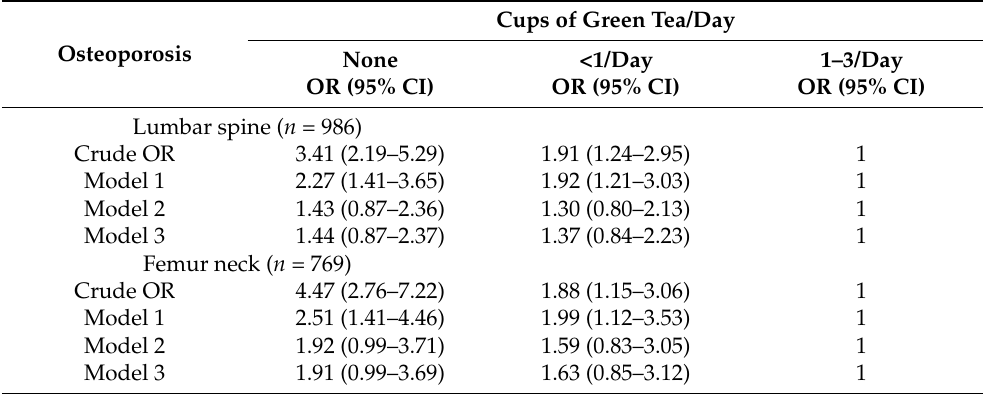
Table 5. The odds ratios for osteoporosis according to green tea